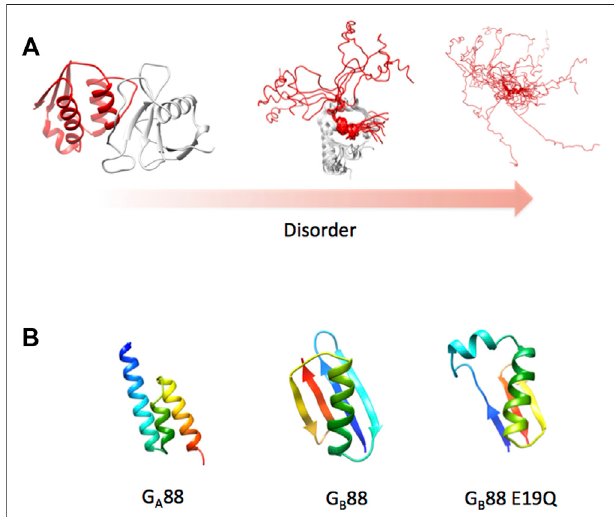
FIGURE 3 | Protein structure and disorder. (A) As discussed in the text, theconceptofanativestatehasbeenrecentlyenriched bytheidenti fi cationof a disorder that characterizes several proteins. To exemplify this concept, we report three different cases characterized by a remarkable difference in the protein disorder. The pbd codes of the different cases are 1ay7, 2ly4, and 2fft(fromlefttoright). (B) 3DstructureofG α 88,G β 88,andthevariantE19Qof G β 88 as predicted by the AlphaFold algorithm. Structures were obtained at the web server reported in Mirdinta et al.